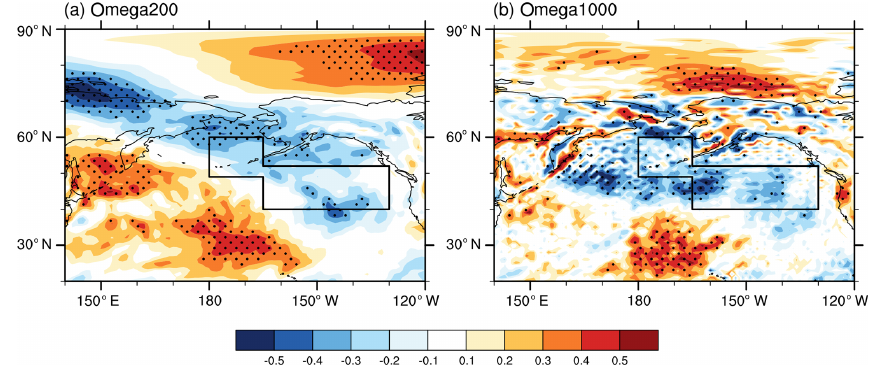
Figure 11. The CC between November SST BA and (a) omega (vertical velocity) at 200hPa and (b) at 1000hPa in December and January from 1979 to 2015. The black dots indicate that the CCs exceeded the 95% confidence level ( t test). The linear trend was removed. The black box represents the BA area.